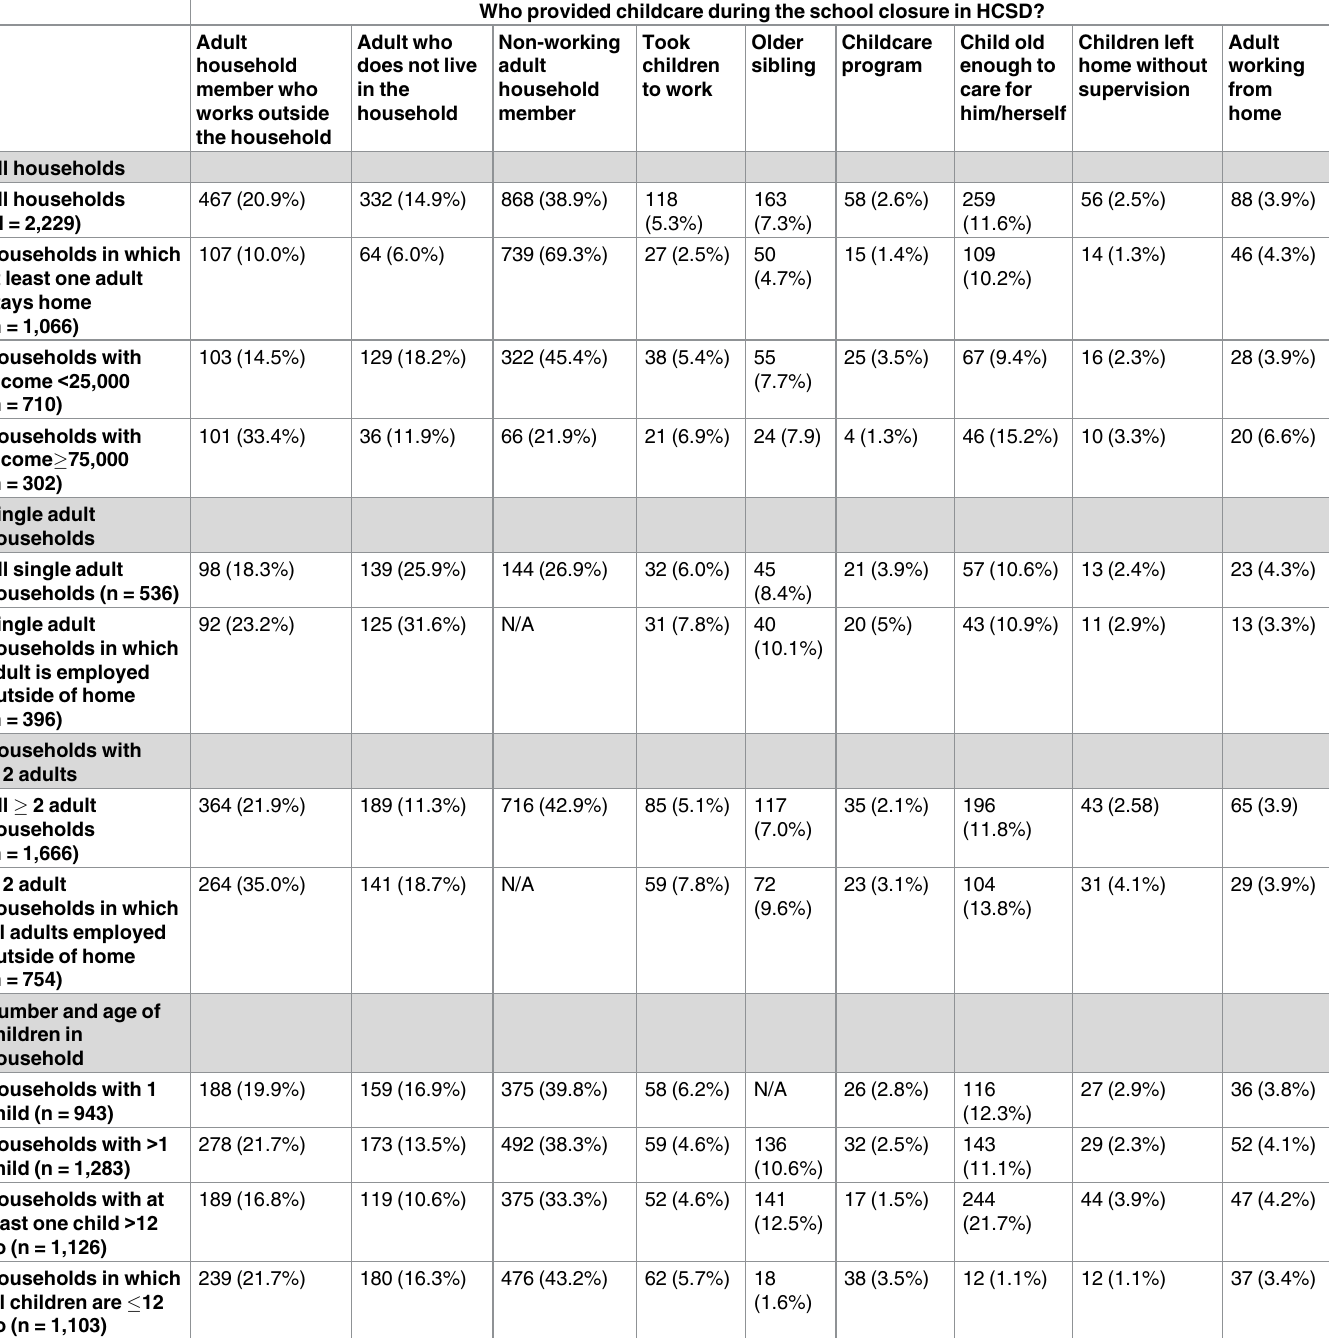
Table 6. Frequency of using alternative childcare options by selected household characteristics. Harrison County SchoolDistrict, Mississippi, August 2012.